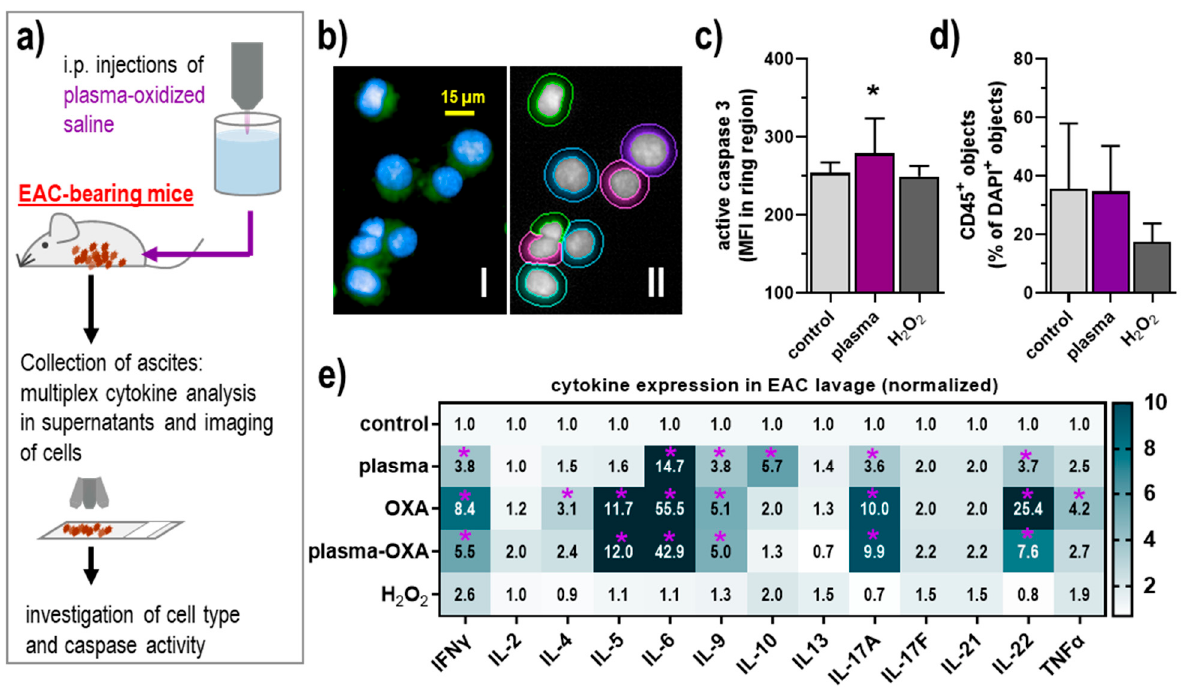
Figure 3. Plasma-oxidized saline showed no acute toxicity in the lavage of EAC-bearing mice while significantly altering the inflammatory profile in the peritoneal cavity. ( a ) Schematic overview of experimental procedures; ( b ) representative images of cells from lavage liquids of EAC-bearing mice with nuclear counterstaining (DAPI, blue) and active caspase 3 stainings (green), and software-based segmentation of cells; ( c , d ) quantification of the staining of active caspase 3 ( c ) and CD45 ( d ) in cells explanted from EAC-bearing mice that received injections of plasma-oxidized or untreated saline; ( e ) 13-plex cytokine quantification of supernatants of lavages with data normalized to controls. Data are mean + SEM of at least three mice per group, statistical analysis was performed using one-way ANOVA with p < 0.05 (*), or two-way ANOVA with p < 0.05 (*, purple) for more than three-fold changes. EAC = Ehrlich Ascites Carcinoma, OXA = oxaliplatin, i.p. = intraperitoneal, p(lasma)-OXA = plasma + oxaliplatin, IL = interleukin, IFN = interferon, TNF = tumor necrosis